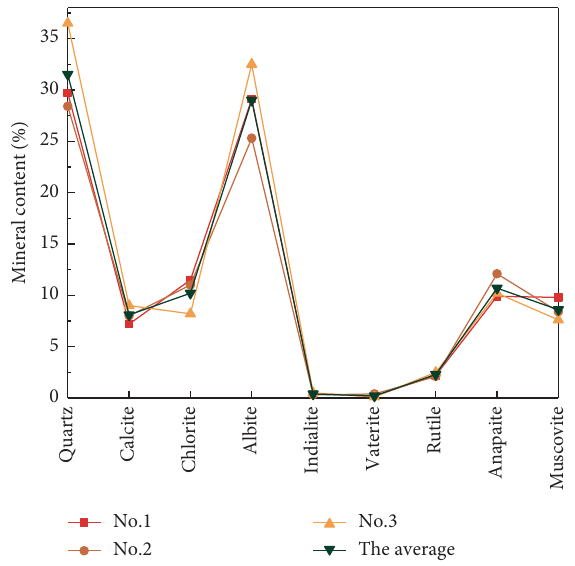
Figure 4: Mineral composition analysis diagram.